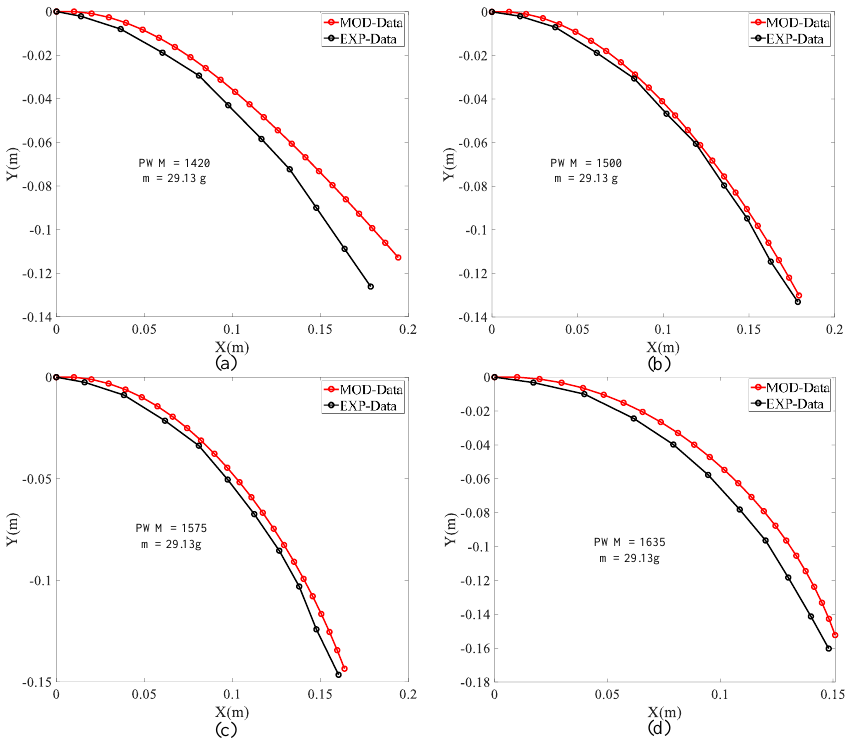
Figure 9. ( a – d ) shown the comparison of experimental and model analysis results for the same mass loads suspended from the middle of the soft